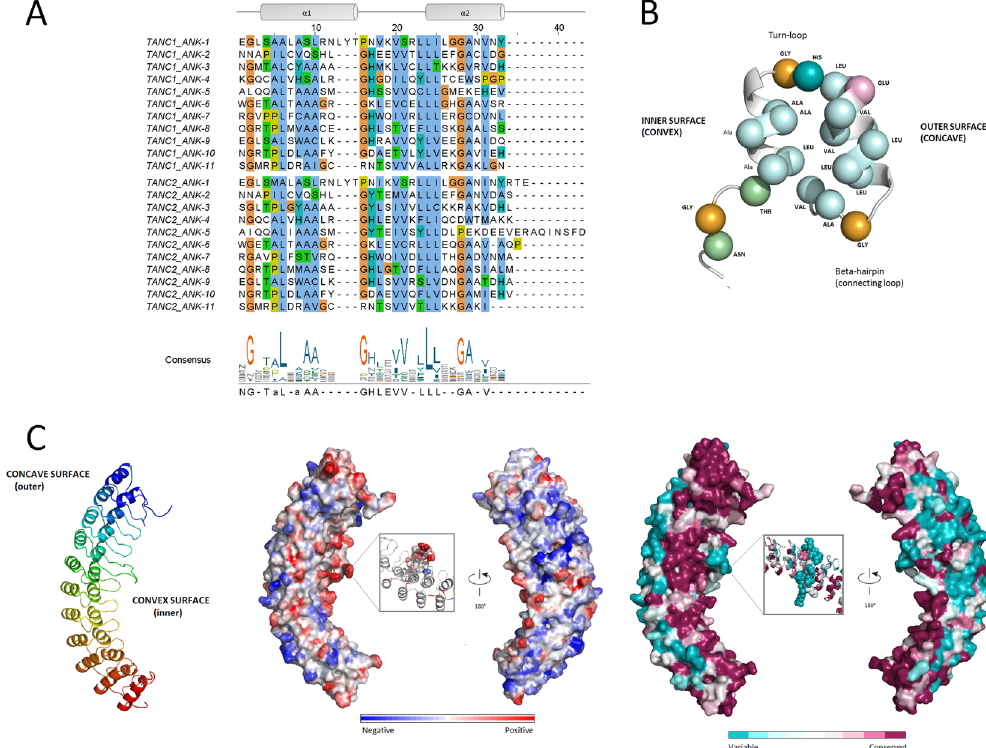
Figure 4. Ankyrin repeat overview and TANC1 Ankyrin domain model. ( A) Consensus sequence of TANC ankyrin modules and related sequence logo. Residues that match the published consensus 57 are reported in upper case. Secondary structure is shown above the alignment: the inner alpha helix ( α 1) and the outer alpha helix ( α 2) are connected by a turn-loop (black line). ( B) Graphic representation of ANK repeats structure in TANC proteins. Conserved positions of ankyrin consensus pattern are reported in the diagram as spheres. Colour code refers to consensus logo: hydrophobic amino acids (A, L and V) are in light blue, glycine in orange, threonine and asparagine in green, histidine in teal, glutamate in violet, and proline in yellow. Residues matching the published consensus 57 are reported in bold. ( C) Cartoon of TANC1 AR domain model is coloured from N-terminus (blue) to C-terminus (red). Electrostatic properties of turn-loop surfaces and connecting-loop surfaces are shown: negative charges in blue and red charges in red. Consurf analysis of turn-loop surface and connecting-loop surface, colour code from unconserved (cyan) to conserved (purple)